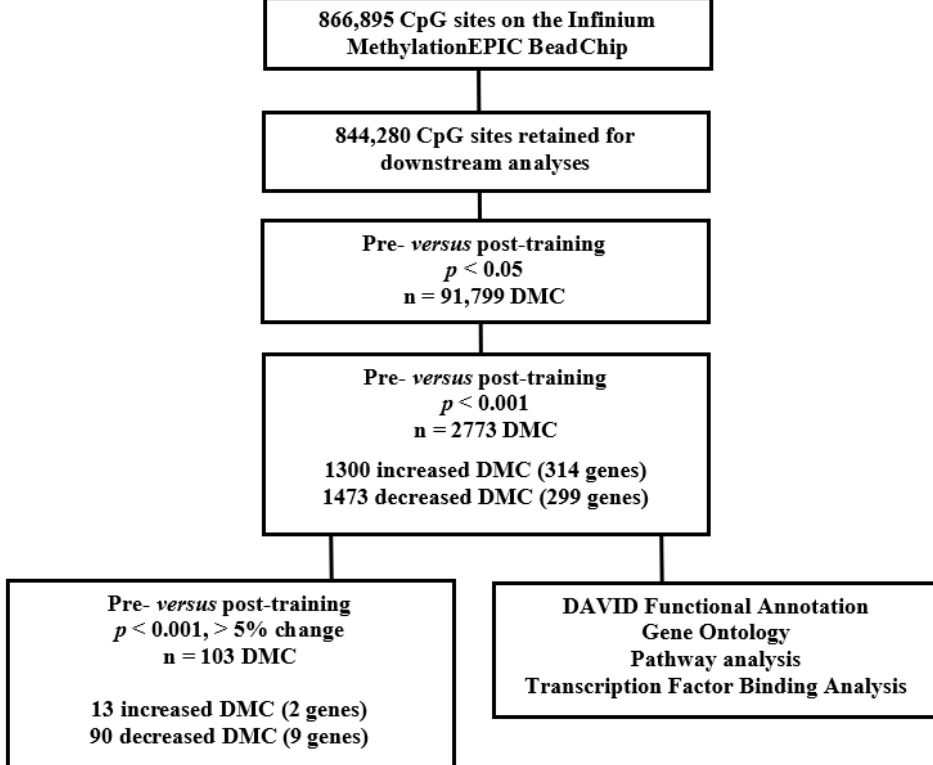
Figure 4. Workflow of methylation analysis. DMC = differentially methylated cytosine. Table 3. Differentially methylated cytosines (DMCs, p < 0.001 and >5% change) following exercise training.